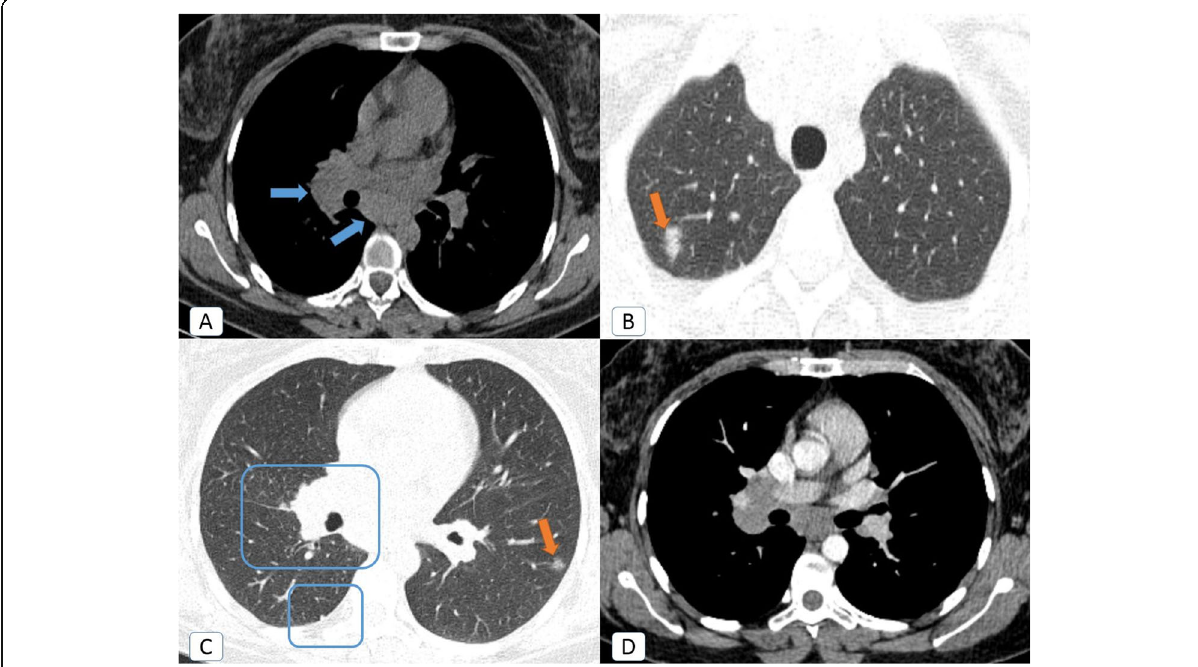
Fig. 2 COVID-19 infection on top of incidentally discovered sarcoidosis: a 43-year-old female COVID-19 patient. A Initial axial chest CT (mediastinal window) showing enlarged right hilar and sub-carinal lymph nodes (blue arrows), B lung window CT cut revealed right apical small ground glass patch (orange arrow), C lung window CT at lower level revealed: enlarged right hilar shadow with nearby nodular fissural thickening and lower lobar pleural based nodule (blue squares) as well as left lateral basal sub-pleural small ground glass patch, D follow up contrast- enhanced chest CT after one month and resolution of the ground-glass patches showed persistent enlarged mediastinal and right hilar